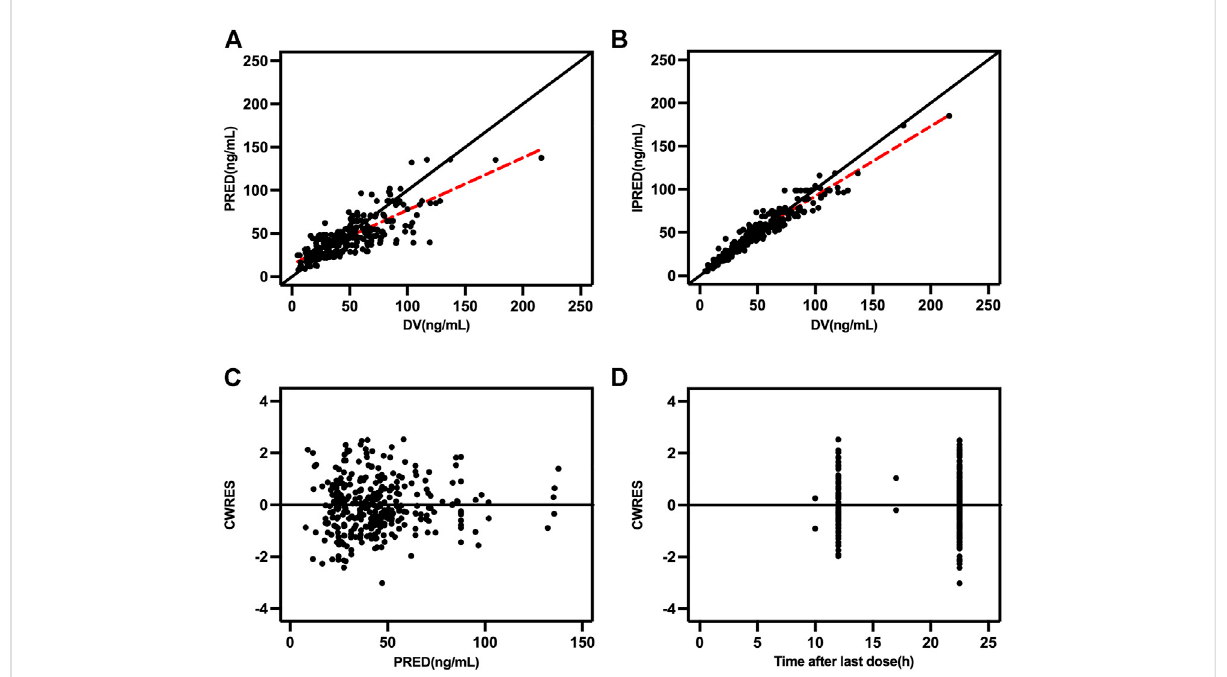
FIGURE 2 Goodness-of- fi t plots (A) Population predicted concentration (PRED) versus observed concentrations; (B) individual predicted concentration (IPRED)versusobservedconcentrations; (C) populationpredictedconcentrationsversusconditionalweightedresiduals(CWRES);and (D) time-after last dose versus